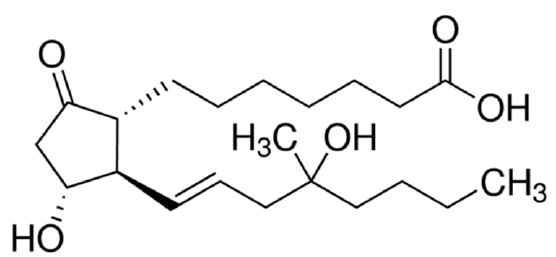
Figure 1. Misoprostol chemical structure. ( ± )-15-deoxy-(16RS)-16-hydroxy-16-methyl prostaglandin E1 [17].